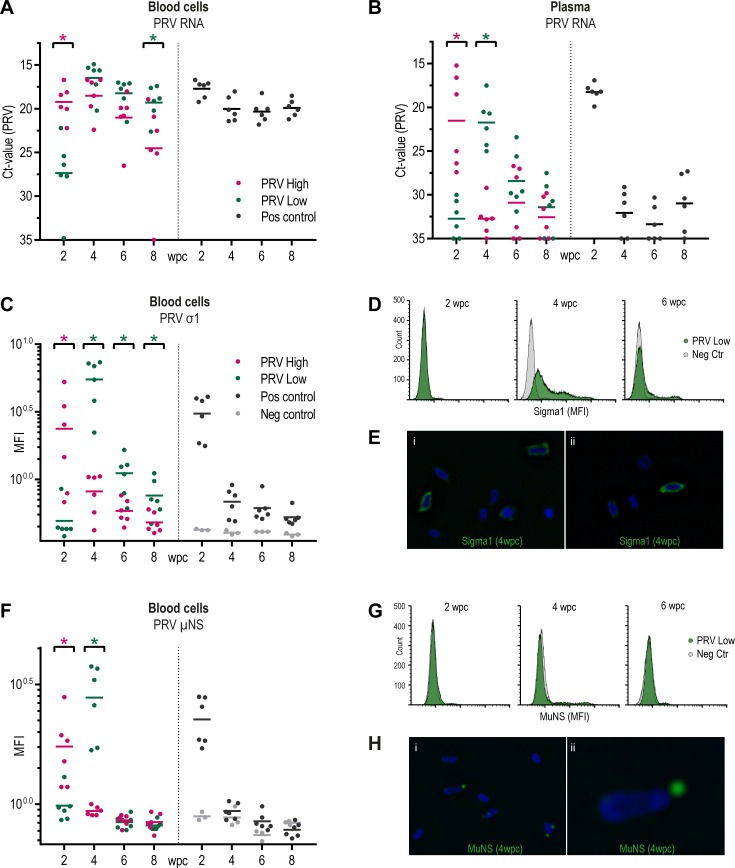
Analysis of blood from injected fish in challenge experiment #2.(A) Blood cells, (B) Plasma: PRV RNA measured by RT-qPCR, shown as individual and mean Ct-values from 2 to 8 weeks post challenge (wpc) (C) Amount of σ1-protein in blood cells measured by flow cytometry, shown as mean fluorescence intensity (MFI) for individual fish and group mean. (D) The results from one individual at 2, 4 and 6wpc from PRV-Low (green) and negative control (grey) groups are presented to illustrate the staining pattern. The fluorescence intensity on X-axis and cell count on y-axis, counting 30 000 cells per sample. (E) Fluorescent labeling of the PRV ơ1-protein (green) in blood cells at 4wpc from PRV-Low. Nuclei stained with Hoechst (blue). The results from μNS staining are presented as for σ1; (F, G) Flow cytometry, (H) Immunofluoresence staining observed by IF microscopy. Statistical analysis comparing PRV-High and PRV-Low was performed using Mann-Whitney test at each time point, *p < 0.05, asterisk color (red and green) indicate the significantly higher group (n = 6).